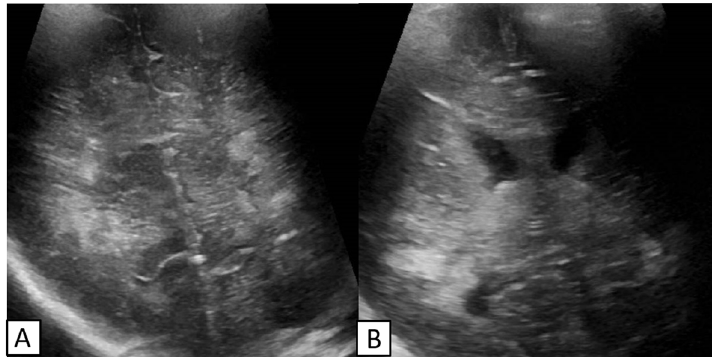
Fig. 3 CUS images at slightly different levels ( A , B ) in a pre-term neonate showing patchy hyperechogenicities in bilateral periventricular white matter suggestive of PVL